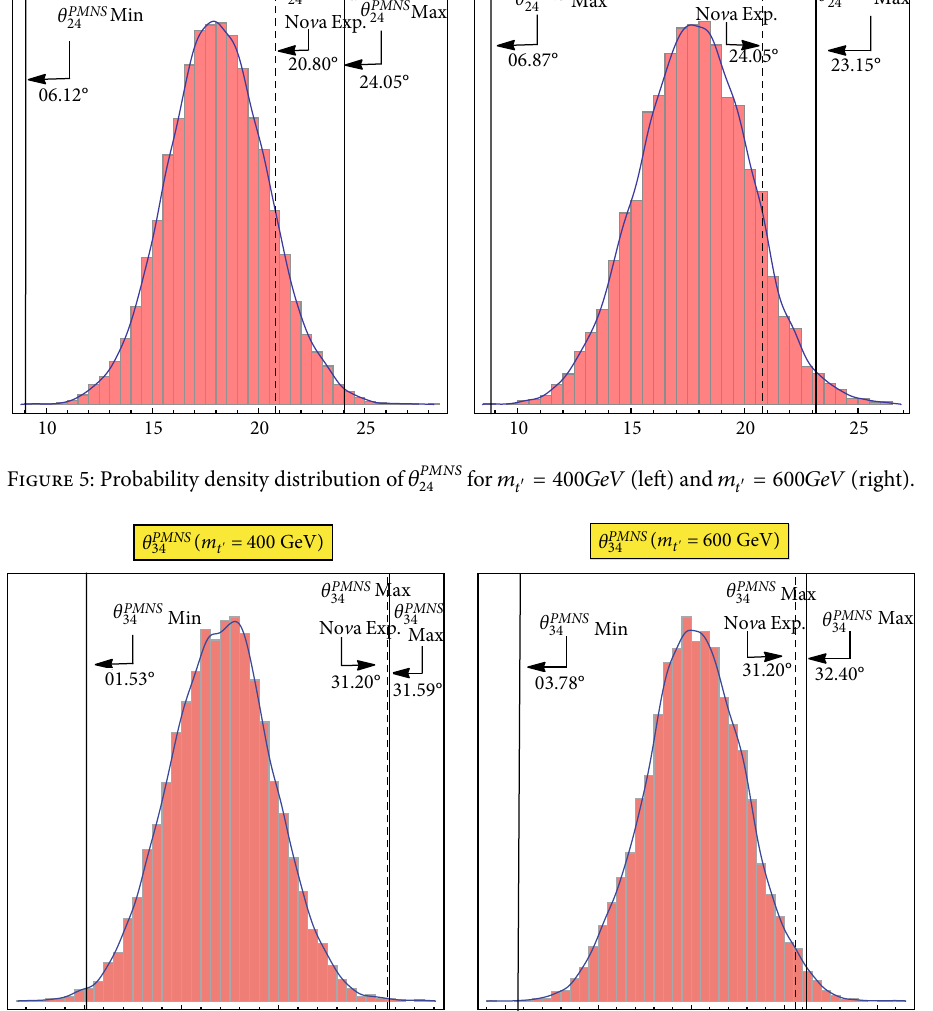
Figure 6: Probability density distribution of 𝜃 𝑃𝑀𝑁𝑆